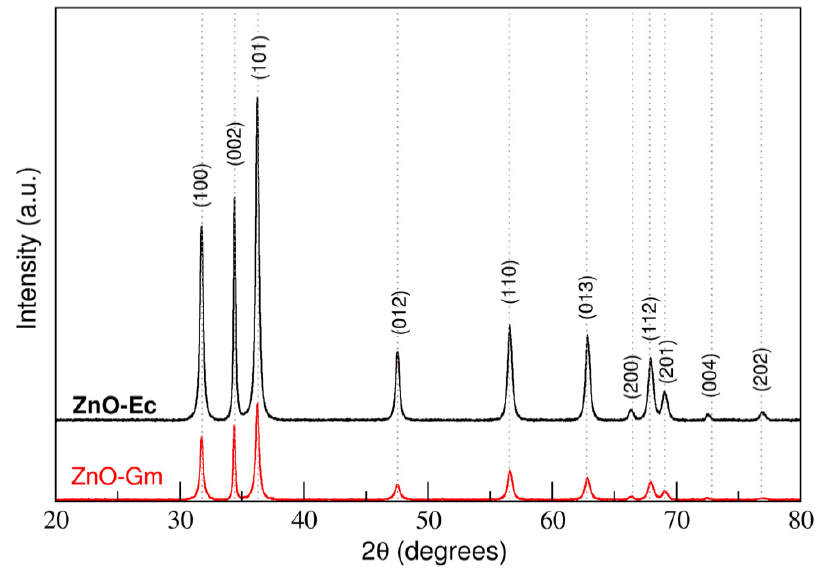
Figure 2. XRD analysis of synthesized ZnO particles prepared by mangosteen ( G. mangostana ) peel extract, ZnO-Gm; and whole water hyacinth ( E. crassipes ), ZnO-Ec. Next, Rietveld refinement was used to calculate the lattice parameters and crystalline sizes of the synthesized ZnO NPs using MAUD software. ZnO-Gm and ZnO-Ec had lattice parameters of a = 3.2536 Å, c = 5.2155 Å, and a = 3.2545 Å, c = 5.2126 Å, respectively. ZnO- Gm (290.42 Å) showed slightly smaller estimated crystalline sizes than ZnO-Ec (318.99 Å).